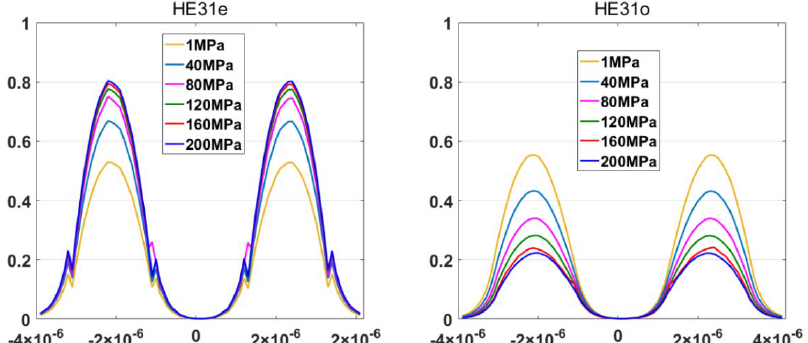
Figure 8. The normalized intensity distribution for the odd mode of HE31 under 1–200 MPa stress in the y direction. Crystal 2019 , 6 , x FOR PEER REVIEW